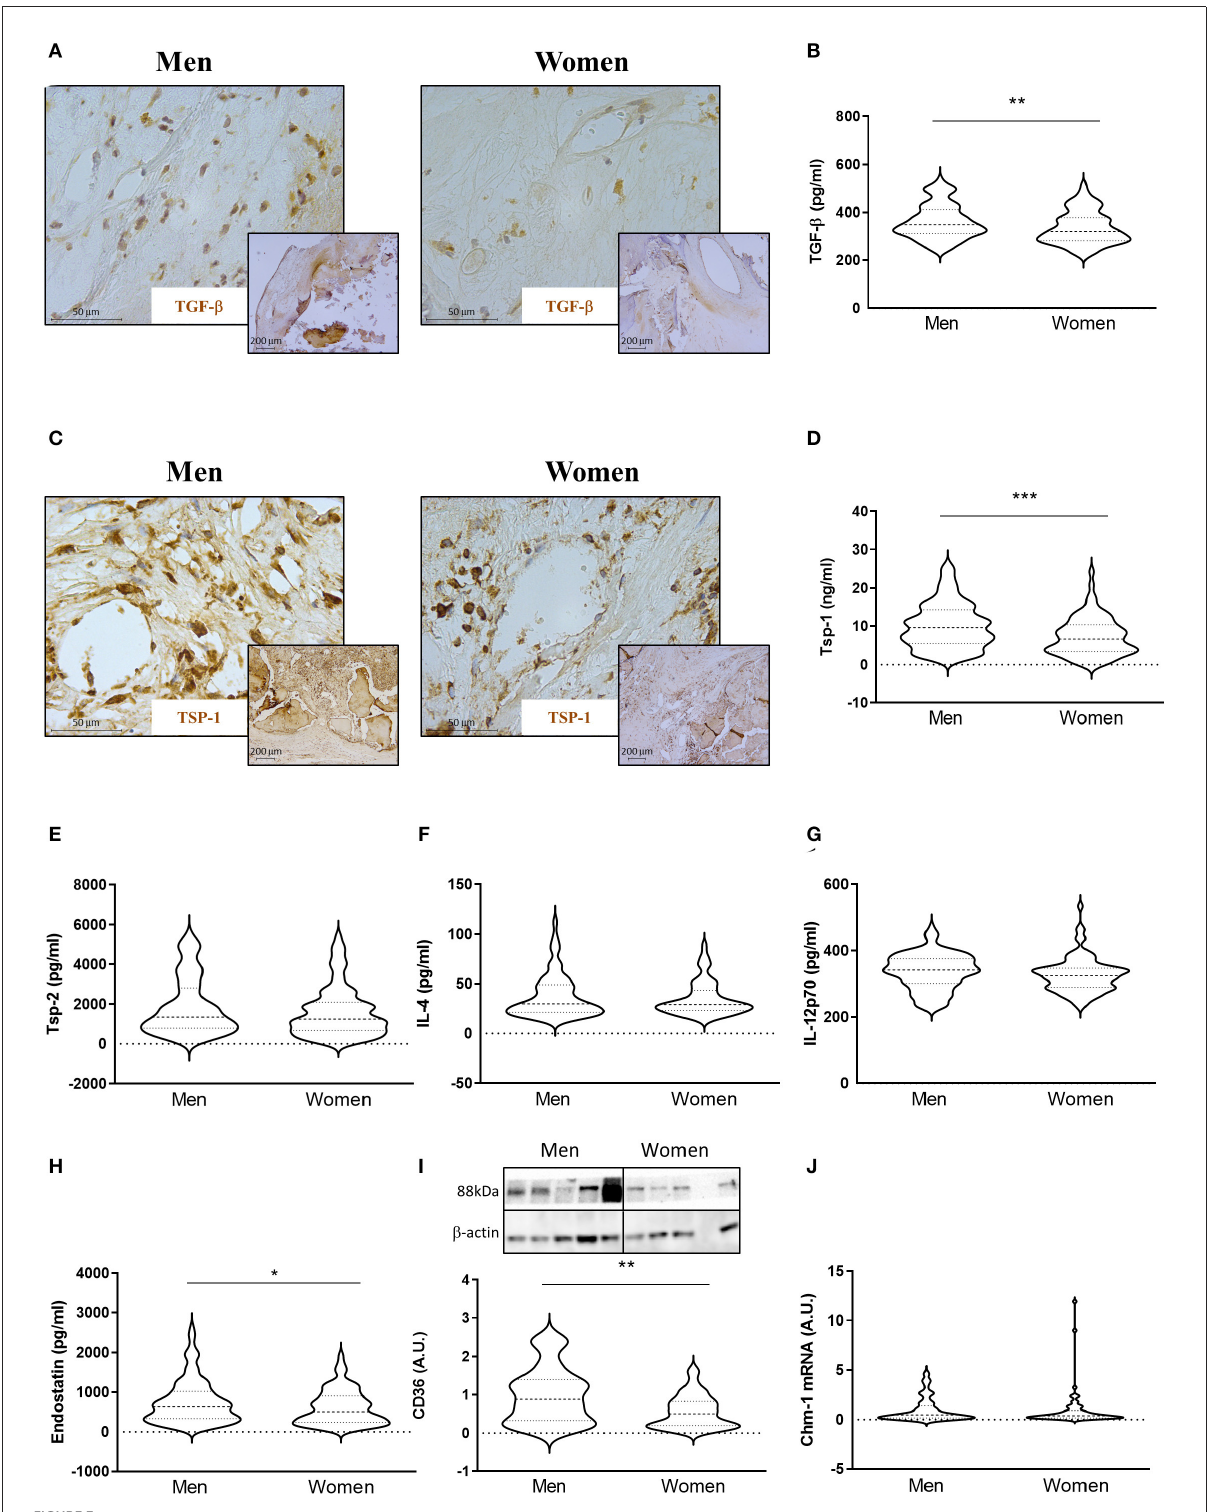
FIGURE3 Sex differences in anti-angiogenic markers in AVs from AS patients. Representative microphotographs of AV sections from AS patients immunostained for TGF- β (A) and Tsp-1 (C) . Protein expressions of TGF- β (B) , Tsp-1, Tsp-2, IL-4, IL-12p70, and endostatin (D–H) in tissue homogenates from AVs of AS patients were measured by ELISA. Protein expression levels of CD36 by WB (I) and mRNA levels of Chm-1 (J) in AVs of AS patients. TGF- β , transforming growth factor-beta; Tsp, thrombospondin; IL, interleukin; Chm-1, chondromodulin-1. Different sample sizes were assayed depending on the analytical methods used. N = 132 for men and N = 86 for women by ELISA. N = 42 men and N = 43 women by WB. N = 11 men and N = 62 women by RT-qPCR. * p < 0.05 vs. men, ** p < 0.01 vs. men, *** p < 0.001 vs.